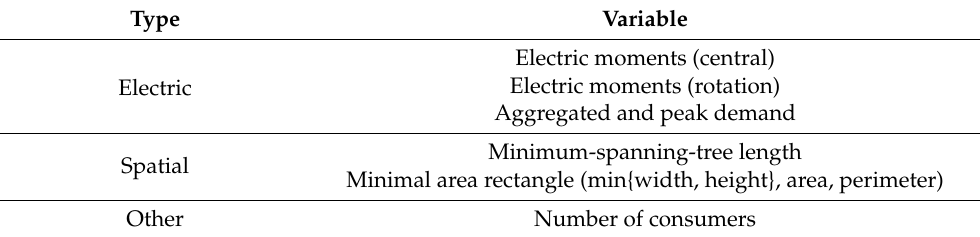
Table 1. Mini-grid